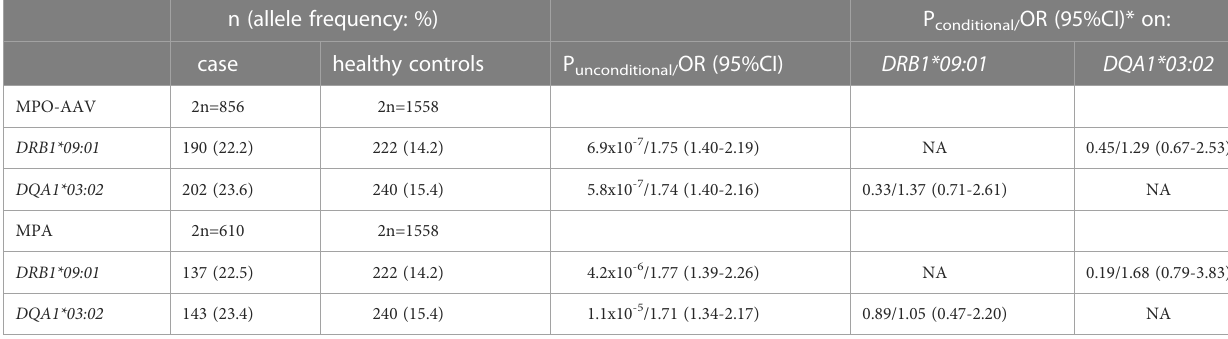
TABLE 2 Association of DQA1*03:02 with susceptibility to MPO-ANCA positive AAV and MPA. n (allele frequency: